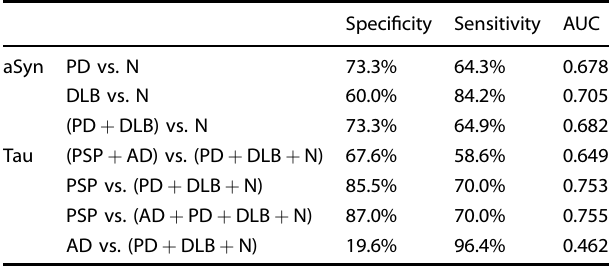
Fig. 9 Calibrated sFIDA results (a, b) and receiver operating characteristic (ROC) analysis (c, d) for the detection of aSyn and Tau aggregates in CSF samples. a For aSyn aggregates, PD, DLB, and AD samples were signi fi cantly elevated compared to normal controls (N). c In ROC analysis, discrimination of PD patients versus normal controls (N) showed a speci fi city of 73% and a sensitivity of 64% with an AUC of 0.68, while discrimination of DLB patients versus normal controls showed a speci fi city of 60% and a sensitivity of 84% with an AUC of 0.71. In combination, synucleinopathies (PD and DLB) can be differentiated from normal controls with a speci fi city of 73% and a sensitivity of 65% with an AUC of 0.68. b , d For Tau aggregates, the tauopathy PSP but not AD can be discriminated from non-tauopathies (for PSP vs. non- tauopathies: 86% speci fi city and 70% sensitivity with an AUC of 0.75; for other speci fi city and sensitivity values s. Table 3). DLB samples showed signi fi cantly increased Tau aggregate concentrations compared to normal controls and PD patients ( p -values of Mann-Whitney U test for aSyn and Tau aggregates are shown in Table 2). Values below the LOD were set to 0. “ - “ indicates the median and “ ○ ” the mean. Signi fi cant differences between cohorts were calculated with Mann-Whitney U test and signed with * (* p = 0.01 – 0.05; ** p = 0.001 – 0.01; *** p < 0.001). Please, note the logarithmic concentration scales. Table 3. Results of ROC analysis for speci fi city, sensitivity and area under the curve (AUC) for aSyn and Tau aggregates in